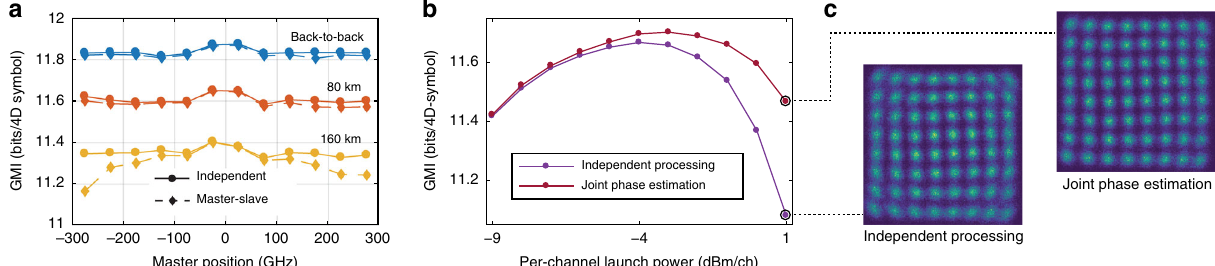
Fig. 4 Joint phase processing transmission results. a Performance comparison of master-slave carrier recovery and independent processing of the same measurements. In the measurements, the center channel was used as the slave while the master was varied between different spectral positions. The GMI of the center channel is plotted as a function of the relative spectral position of the master channel. Optimal launch power ( (cid:1) 4 dBm = ch) is used. b Performance of the center channel as a function of total launch power for joint phase estimation together with its neighbor, compared with independent processing. The transmission distance is 80 km. c Comparison of constellation diagrams for independent and joint